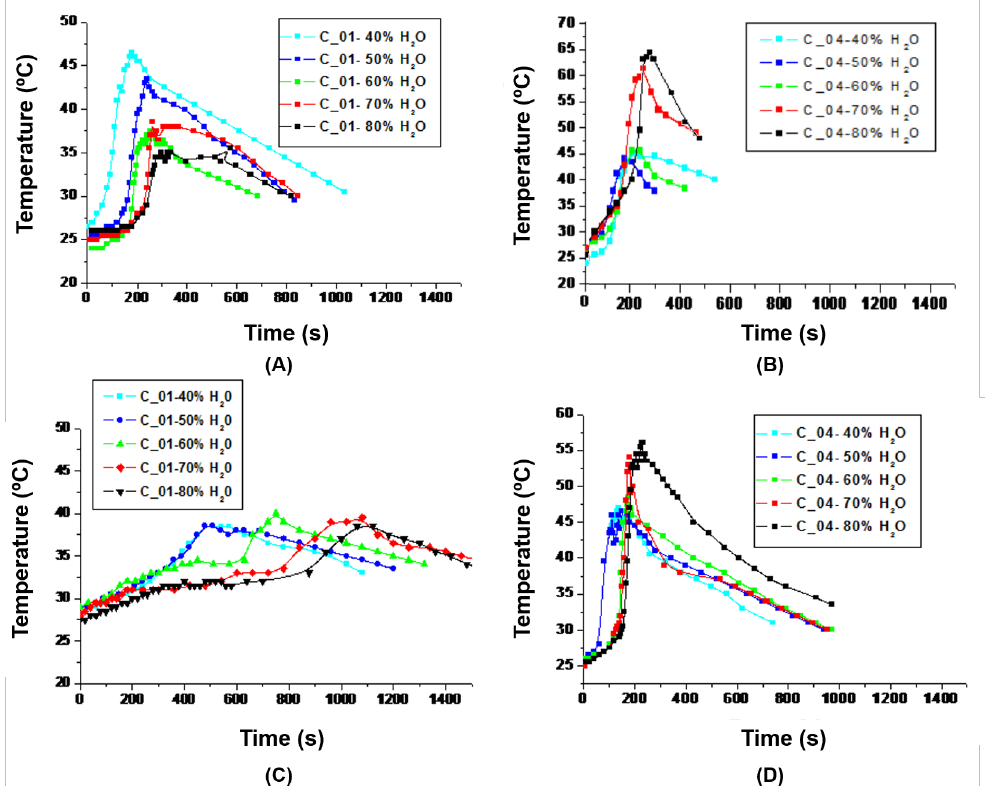
Figure 6. Effect of water content on the temperature evolution of compositions containing MgO powders calcined at 900 ºC / 2 h (A) and (B) and at 1100 ºC /2 h (C) and